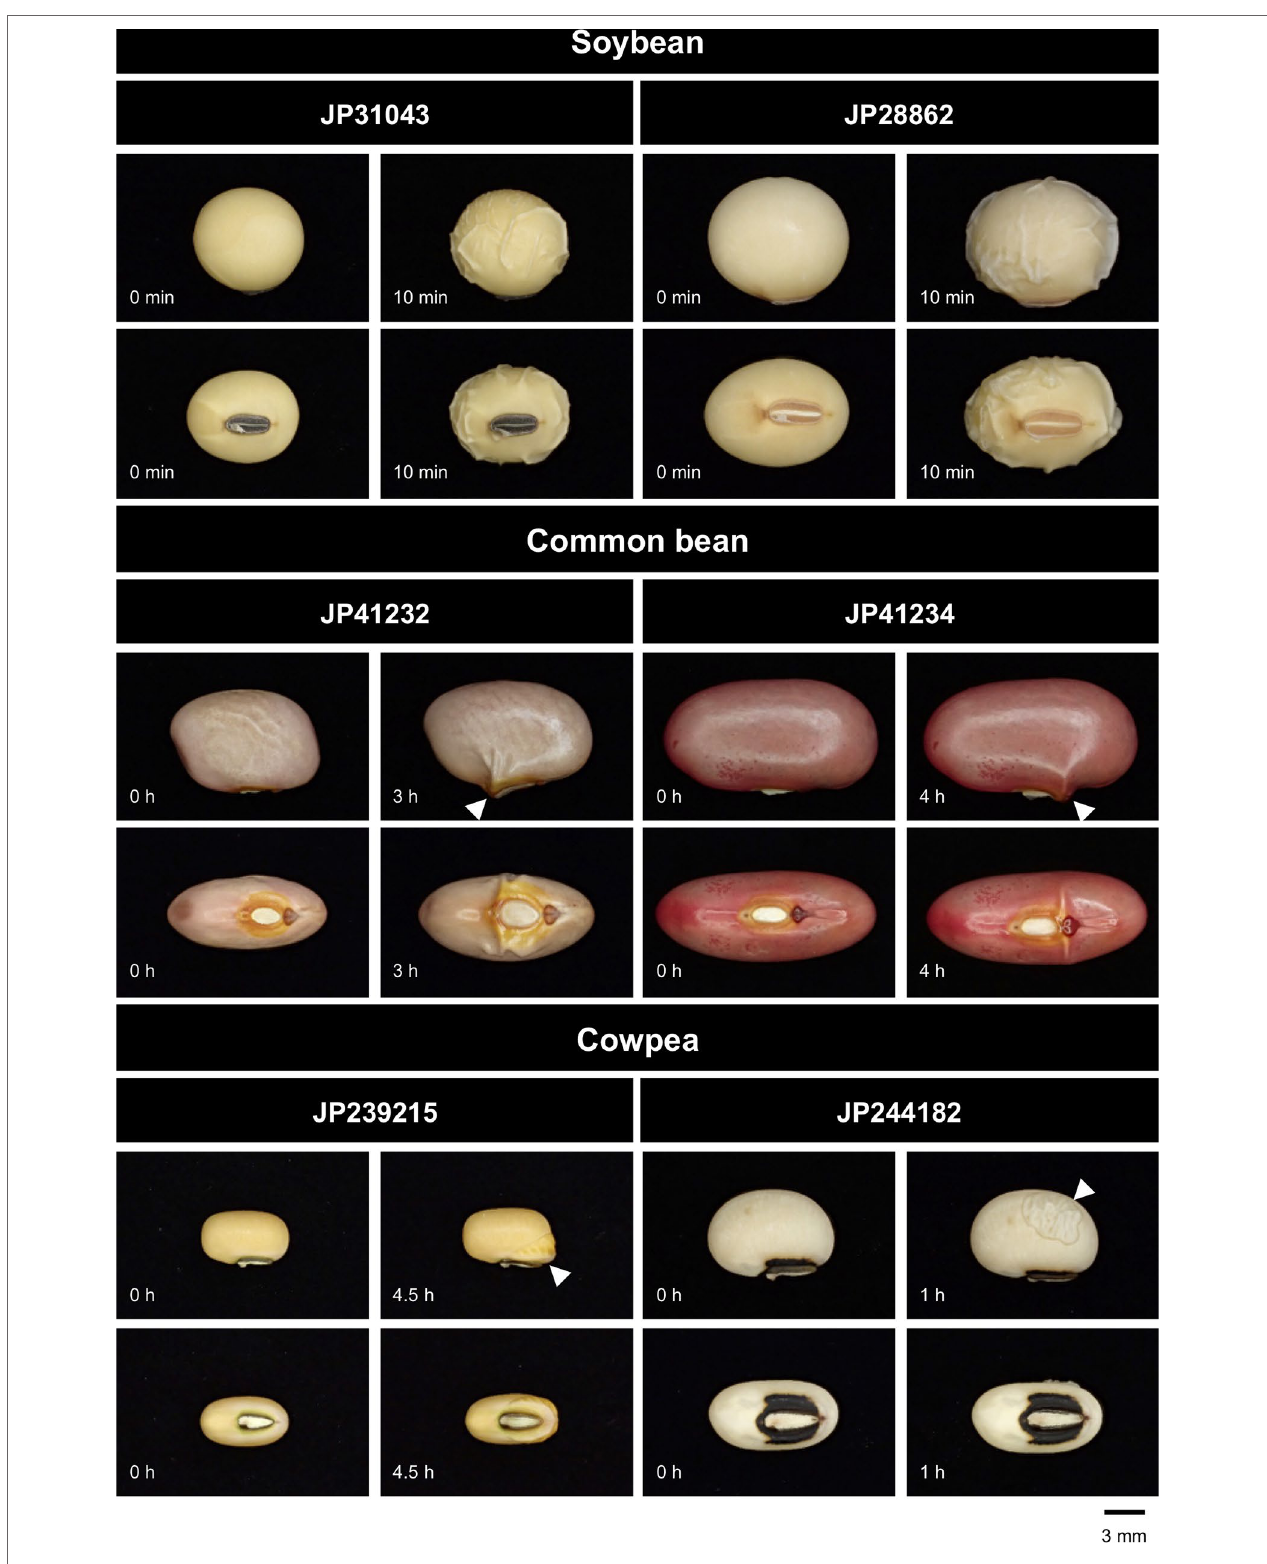
FIgURe 2 | Water entry sites in domesticated legumes. The entry sites (indicated by arrowheads) varied across accessions, but did not vary within accessions.